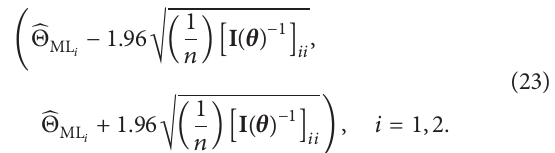
Figure 6: Normalized standard deviation curves for the ML estimators of 𝜅 and 𝜇 . (a) √ Var [̂𝜅 √ Var [̂𝜇 ]| 𝜇 and for 𝜅 = {1, 10} . 𝑛=1 as function of ML